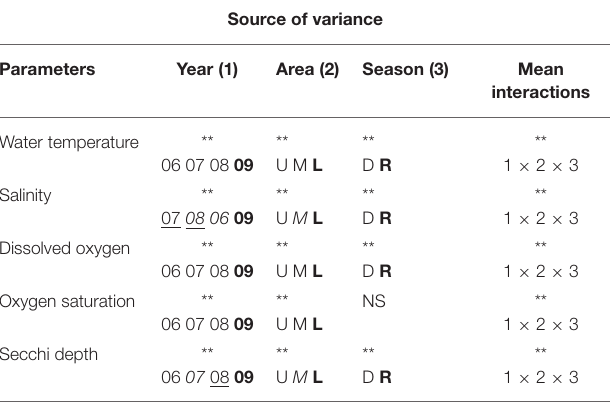
TABLE 1 | Summary of the MANOVA ( F = 3.4; gf = 859) and Bonferroni’s test results for water temperature, salinity, Secchi depth, dissolved oxygen,